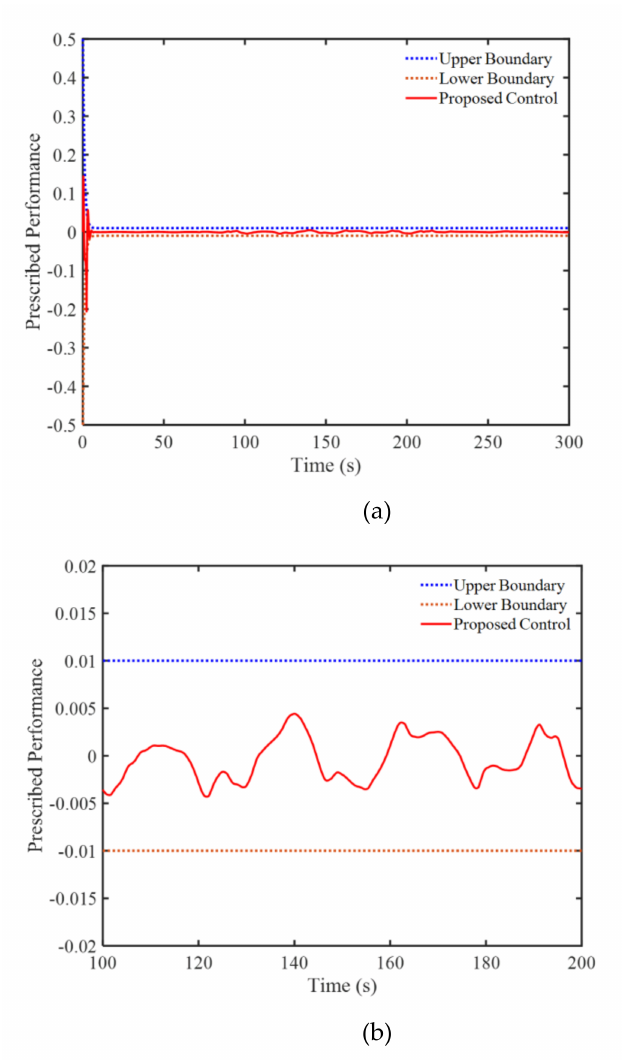
Figure 8. Prescribed performance of the proposed controller: ( a ) general view, ( b ) enlarged